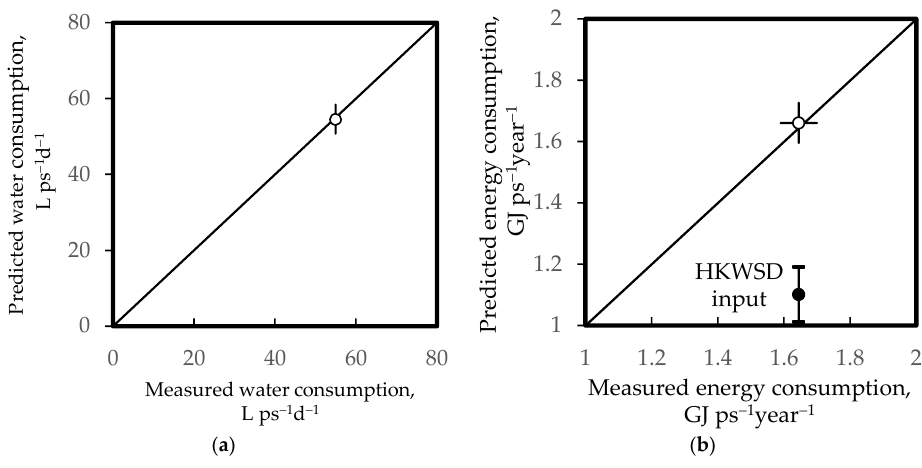
Figure 5. Model validation: ( a ) per capita daily shower water consumption; ( b ) per capita annual hot water energy consumption.